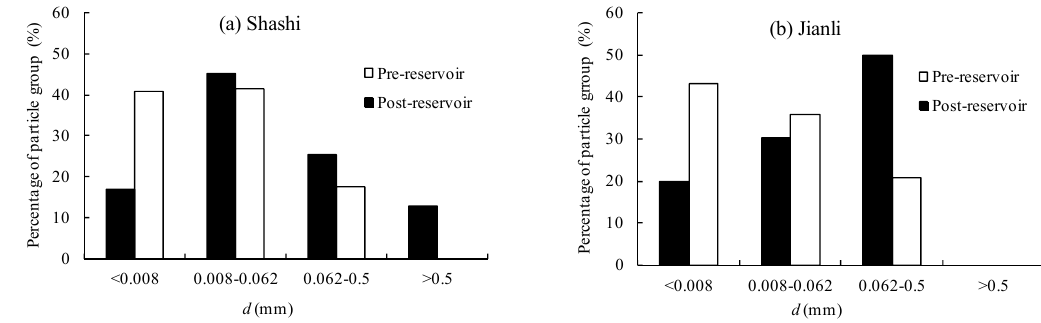
Figure 12. Percentages of particle groups before and after TGD dam operation at Shashi ( a ) and Jianli ( b ) hydrological stations. Data for pre-reservoir are average values between 1991 and 2002, and data for post-reservoir are average values between 2003 and 2016. Water 2017 , 9 , 986